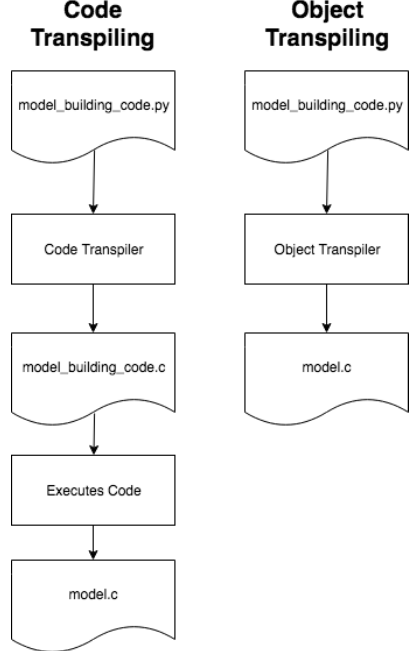
Figure 5. Transpiler’s workflow. The workflow of both transpilers, as it is possible to see, transpiling objects means that the model build part is done directly in the original programming language, and only the data object is